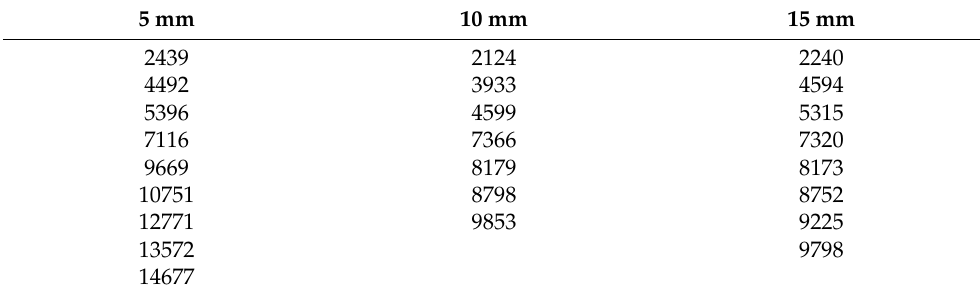
Table 2. Resonant frequencies detected by circular fit method at the border (base) of the membrane (Hz). 5